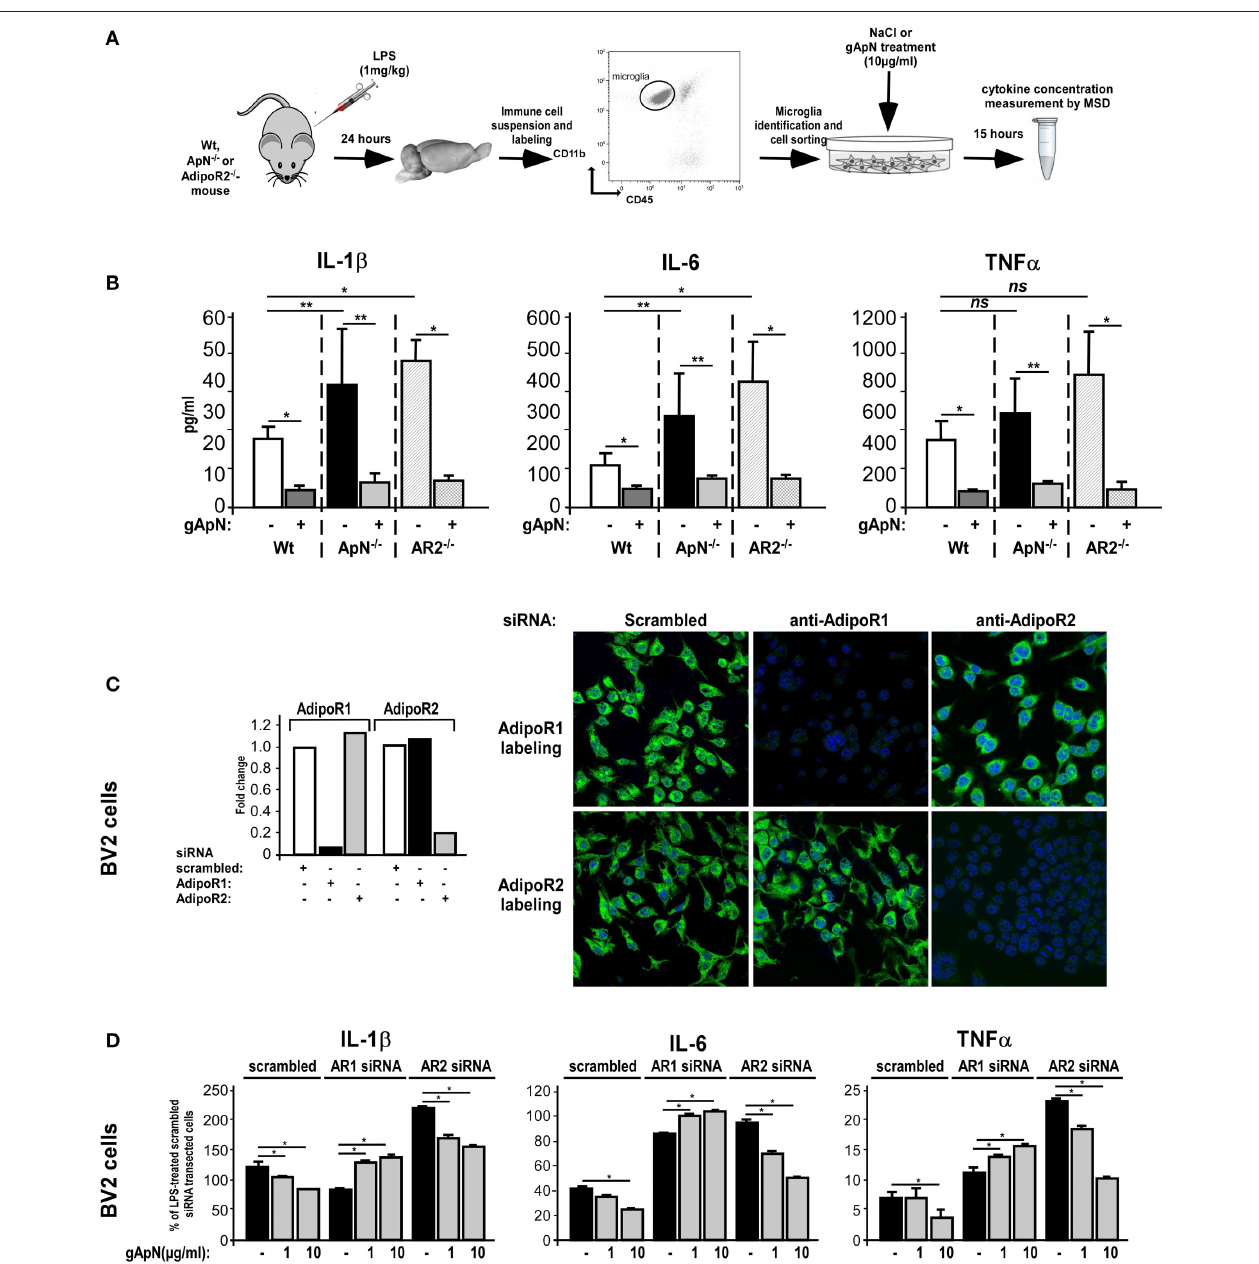
FIGURE 7 | Globular adiponectin anti-inflammatory properties on microglia depend on AdipoR1 expression. (A) Schematic representation of the protocol. Wt, ApN − / − and AdipoR2 − / − mice were ip administered with LPS and microglia was sorted out from mouse brains and cultured in absence or presence of gApN for 15h as described in the Materials and Methods section. (B) Levels of IL-1 β , IL-6, and TNF α proteins released by in vivo LPS-activated and in vitro saline (white, black, and striped bars) or gApN-treated (dark gray, light gray, and double striped bars) microglia were quantified by MSD. N 4–5 per group; Mann & Whitney for = comparison between groups, * p < 0.05. (C) BV2 cells were transfected with scrambled (white bars), AdipoR1 (black bars), or AdipoR2 (gray bars) specific siRNAs as described in the Materials and Methods section. Forty-eight hours after transfection, AdipoR1 and AdipoR2 expression downregulation was verified by qRT-PCR (histograms) and immunocytochemistry (photographs). Photographs show representative images of BV2 cells transfected with scrambled (left panels), AdipoR1 (middle panels), or AdipoR2 (right panels) specific siRNAs labeled with AdipoR1 (green fluorescence, upper panels) or AdipoR2 antibodies (green fluorescence, lower panels). Nuclei are stained with Hoechst blue fluorescent dye. (D) BV2 cells were transfected with scrambled, AdipoR1 or AdipoR2 specific siRNAs, and then pre-treated with saline (black bars) or gApN (gray bars) for 1h before addition of LPS. Levels of IL-1 β , IL-6, and TNF α mRNAs were quantified by qRT-PCR. N 4 per = group, ns, non-significant; Kruskal–Wallis test followed by the Iman-Conover method for multiple comparison between groups was performed, * p < 0.05; ** p < 0.01.